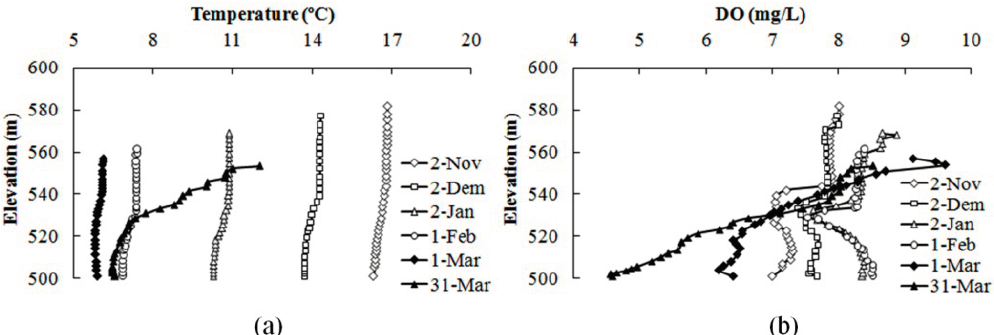
Figure 9. Vertical variation in temperature ( a ) and DO ( b ) in the Heihe Reservoir after the WLAs stopped